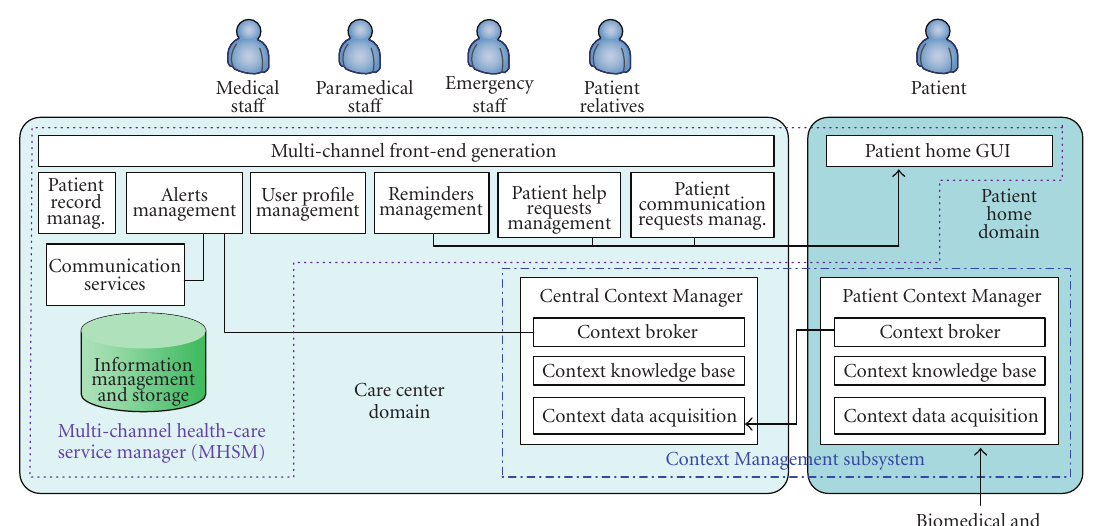
Figure 2: ERMHAN